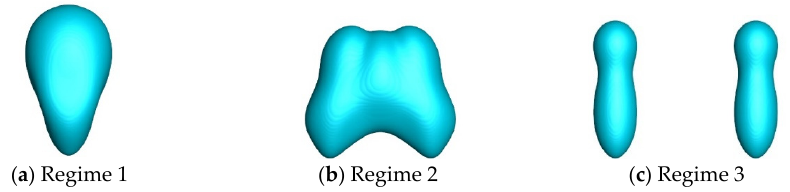
Figure 9. The droplet morphology in each regime. ( a ) Regime 1. ( b ) Regime 2. ( c ) Regime 3.